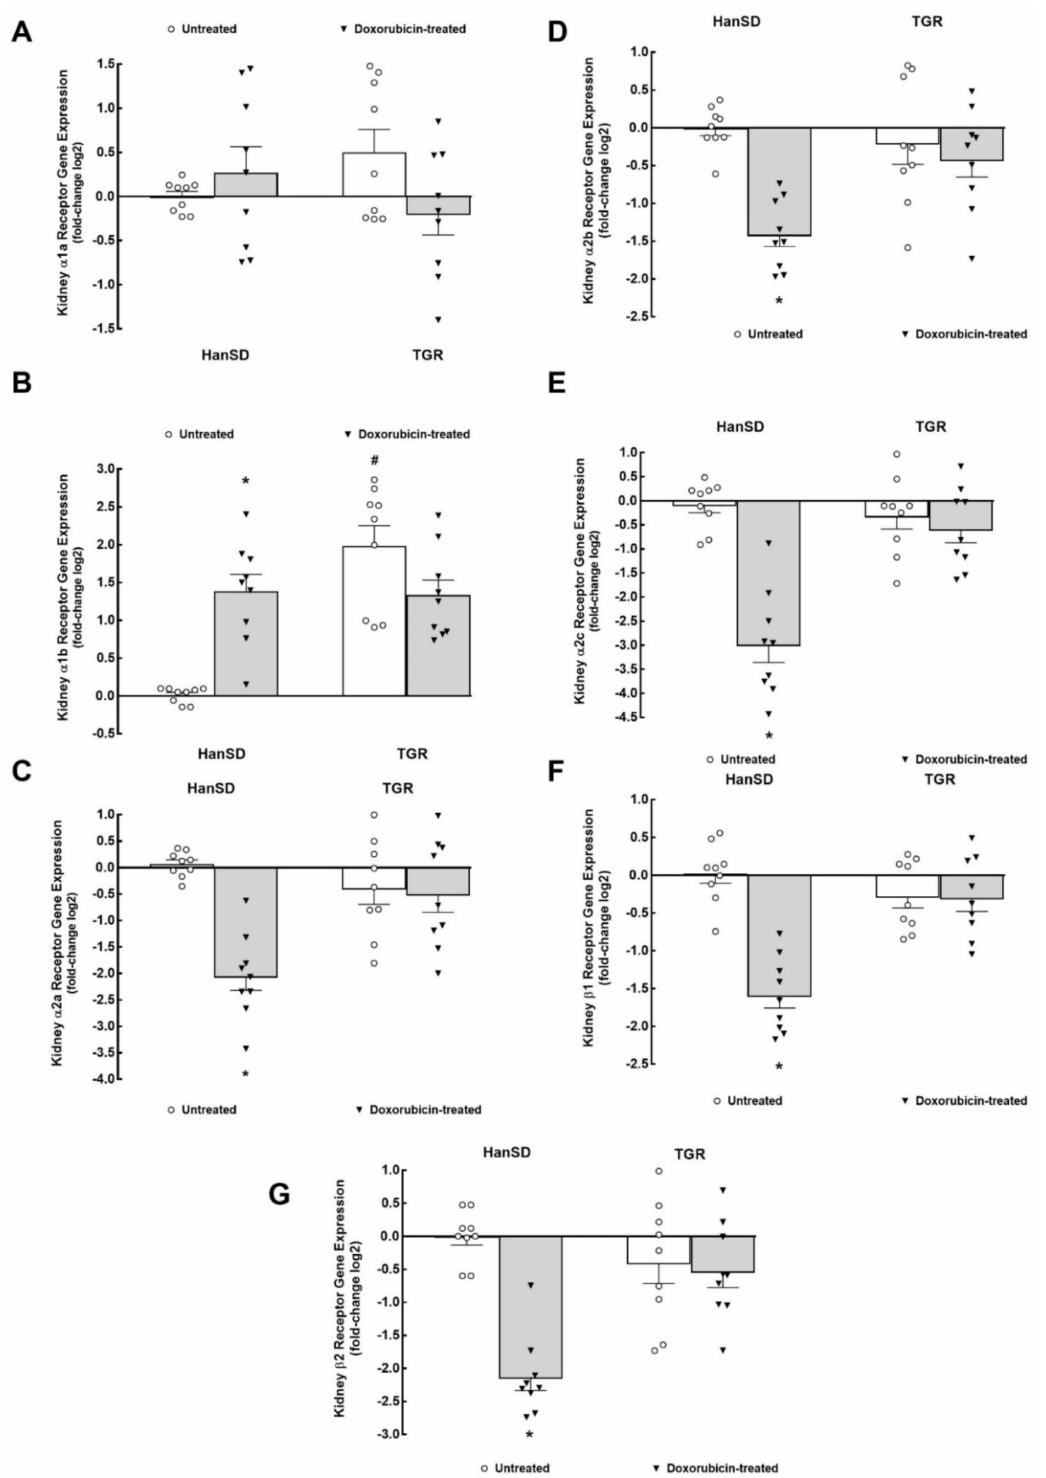
Figure 6. The third part of kidney mRNA expression. Kidney α 1 subtype a ( α 1a) adrenergic receptor ( A ), α 1 subtype b ( α 1b) adrenergic receptor ( B ), α 2 subtype a ( α 2a) adrenergic receptor ( C ), α 2 subtype b ( α 2b) adrenergic receptor ( D ), α 2 subtype c ( α 2c) adrenergic receptor ( E ), β adrenergic receptor type 1 ( β 1) ( F ) and β adrenergic receptor type 2 ( β 2) ( G ) gene expression in untreated and doxorubicin-treated normotensive, transgene-negative Hannover Sprague–Dawley (HanSD) and hypertensive, Ren-2 transgenic (TGR) rats. * p < 0.05 compared with untreated animals of the same strain. # p < 0.05 versus HanSD rats within the same protocol. The values are means ± SEM. Statistical comparison was made by one-way ANOVA